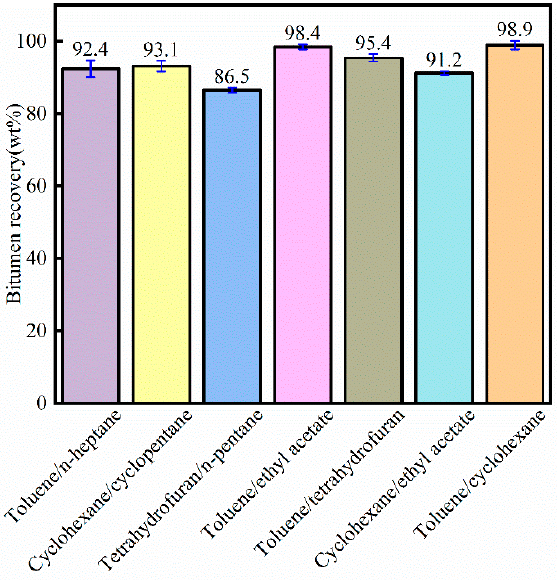
Figure 7. Bitumen recovery by composite solvents for crude bitumen samples